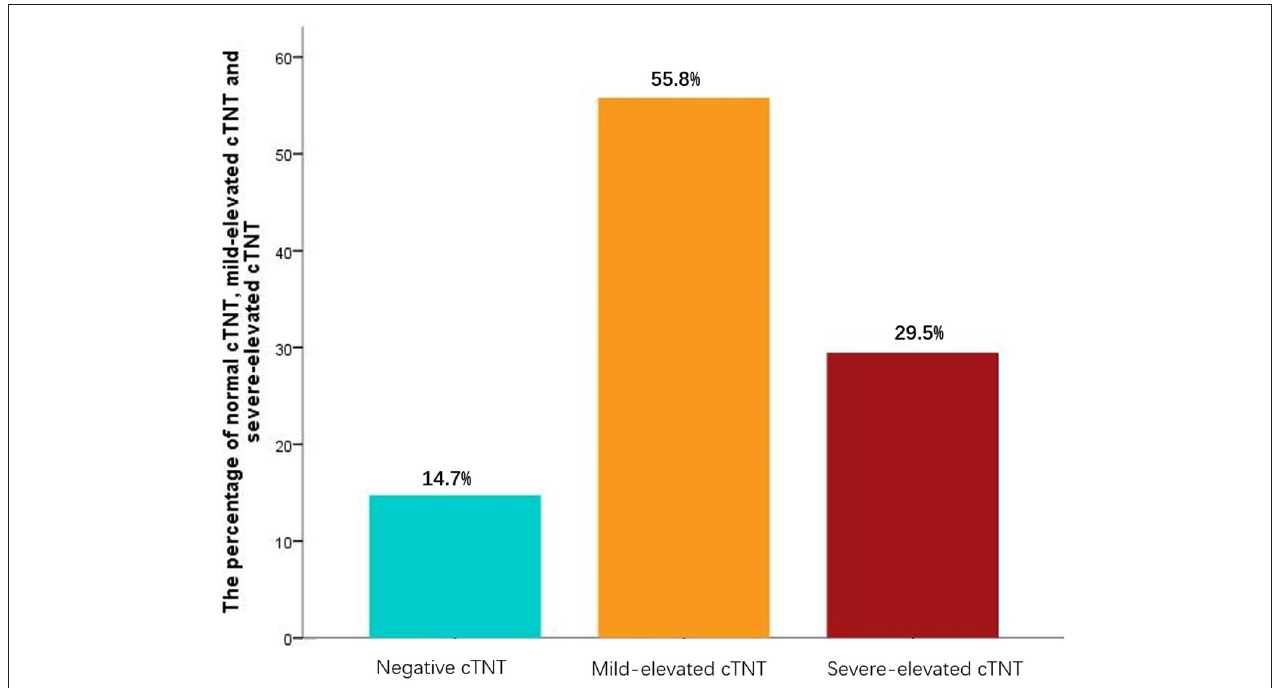
FIGURE 1 | Postprocedure cardiac troponin T (cTNT). Mild-elevated cTNT is defined as post-cTNT higher than 0.03 but lower than 0.09 µ g/L. Severe-elevated post-cTNT is defined as ≥ 0.09 µ g/L. The median and quartile range of postprocedure cTNT was 0.037 µ g/L (0.064–0.108 µ